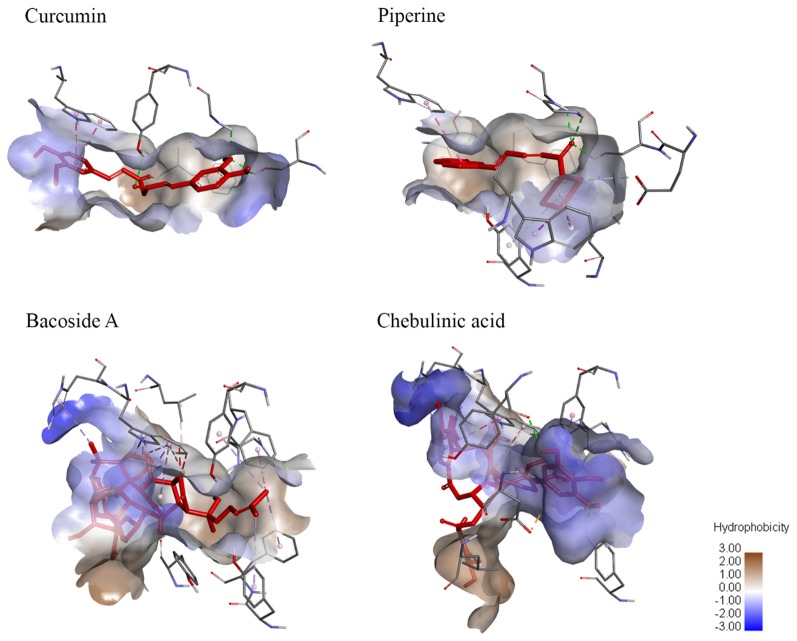
Degree of hydrophobicity on the molecular surface of ligands when bound to AChE. Curcumin and piperine both have similar sizes of areas with low hydrophobicity and areas of low hydrophilicity. Meanwhile, bacoside A has a larger area of hydrophobicity while chebulinic acid has a smaller area of hydrophobicity.